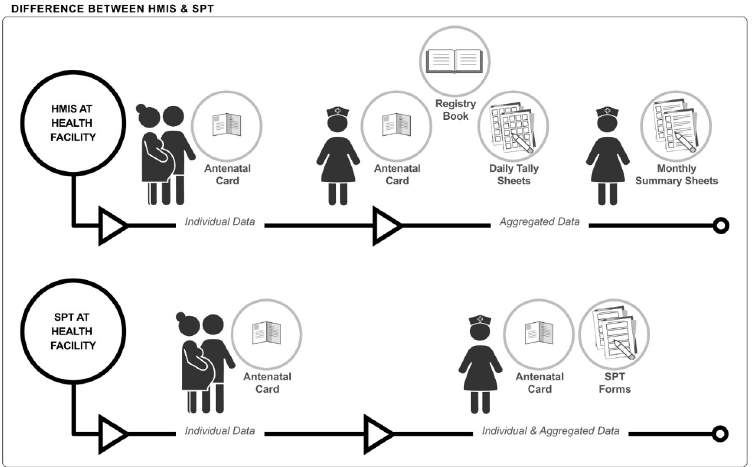
Fig 1. The difference between HMIS and SPT systems at health facility level. HMIS: A nurse documents patient and service information into a woman’s antenatal care card and in a register book. Daily tally sheets and monthly report forms are manually created. The latter are brought to the district headquarter up to 10 th of each month. SPT: A nurse documents patient and service information in a woman’s antenatal care card and on one scannable SPT form. Forms are brought to district headquarter in regular intervals.